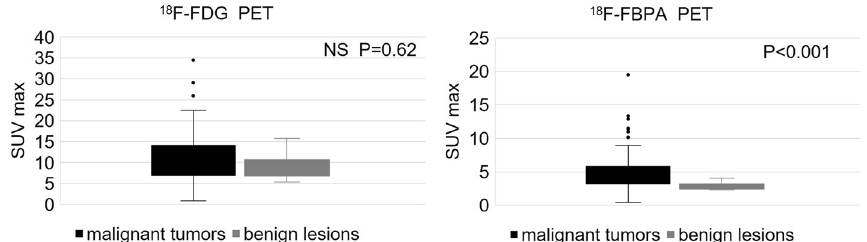
Fig. 3 SUVmax of 18 F-FDG and 18 F-FBPA PET/CT for malignant tumors vs. benign lesions